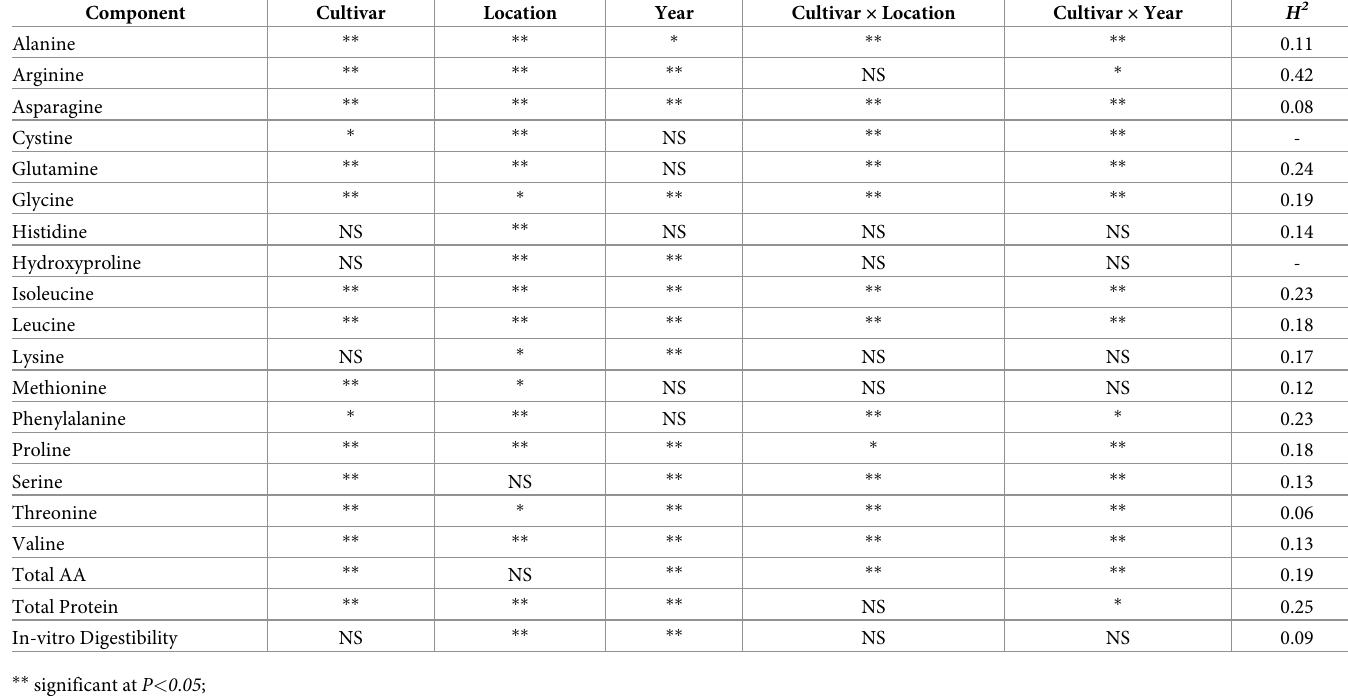
Table 1. Analysis of variance and broad-sense heritability estimates of protein quality traits evaluated for dry pea tested in SC, USA.